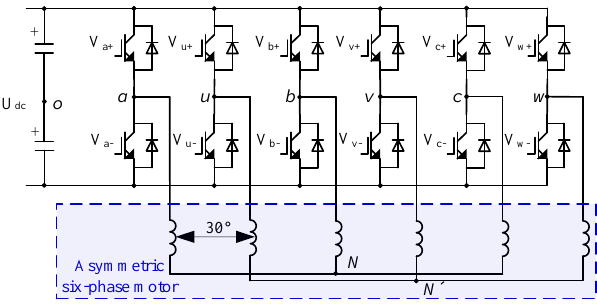
Figure 1. The topology of a six-phase motor fed by a VSI. For two-level six-phase VSI, there are 64 space vectors in total. These vectors are defined by a decimal number that corresponds to a string of binary numbers, namely ( S w S v S u S c S b S a ). The S j ( j = a, b, . . . , w) denotes the switch state of up-branch in phase j , i.e., “ S j = 0” means OFF state and “ S j = 1” means ON state. According to the vector space decomposition (VSD) theory, the physical quantities, such as current, voltage, and flux, in the natural coordinate system are mapped onto three mutually perpendicular planes, namely d-q , x-y , and o 1 -o 2 . The d-q plane contains the fundamental component and the harmonic components with 12K ± 1 (K = 1, 2, 3, . . . ) orders. Harmonic components with 6K ± 1 (K = 1, 3, 5, . . . ) orders are mapped on the x-y plane. On the o 1 -o 2 plane, the harmonic components with the order 6K ± 3 (K = 1, 3, 5, . . . ) are mapped [39]. When the two neutral points are isolated from each other, all the vectors on the o 1 -o 2 plane are at the origin [40]. On the d-q and x-y planes, there are 60 effective space vectors and four zero-vectors (namely 0, 7, 56, and 63), as shown in Figure